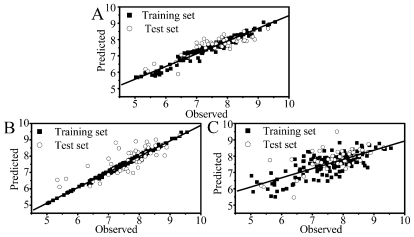
(A) Scatter plot of the predicted versus observed pIC50 values of the RF model; (B) scatter plot of the predicted versus observed pIC50 values of the SVM model; (C) scatter plot of the predicted versus observed pIC50 values of the PLS model.